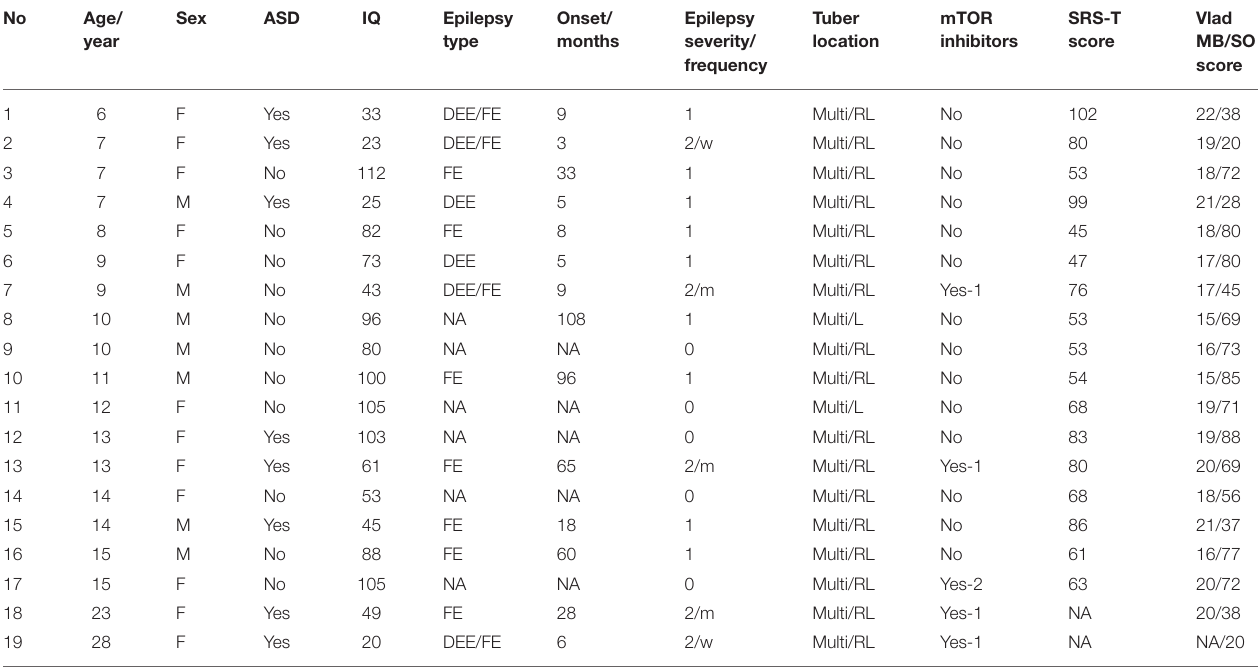
TABLE 2 | Clinical features of the subjects with TSC ( n =